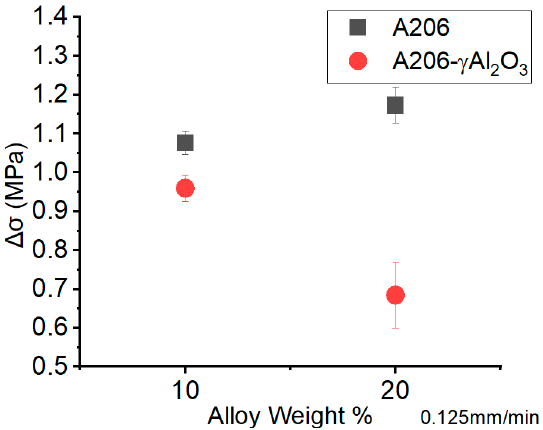
Figure 11. PLC signal amplitude at a 0.125 mm/min strain rate.